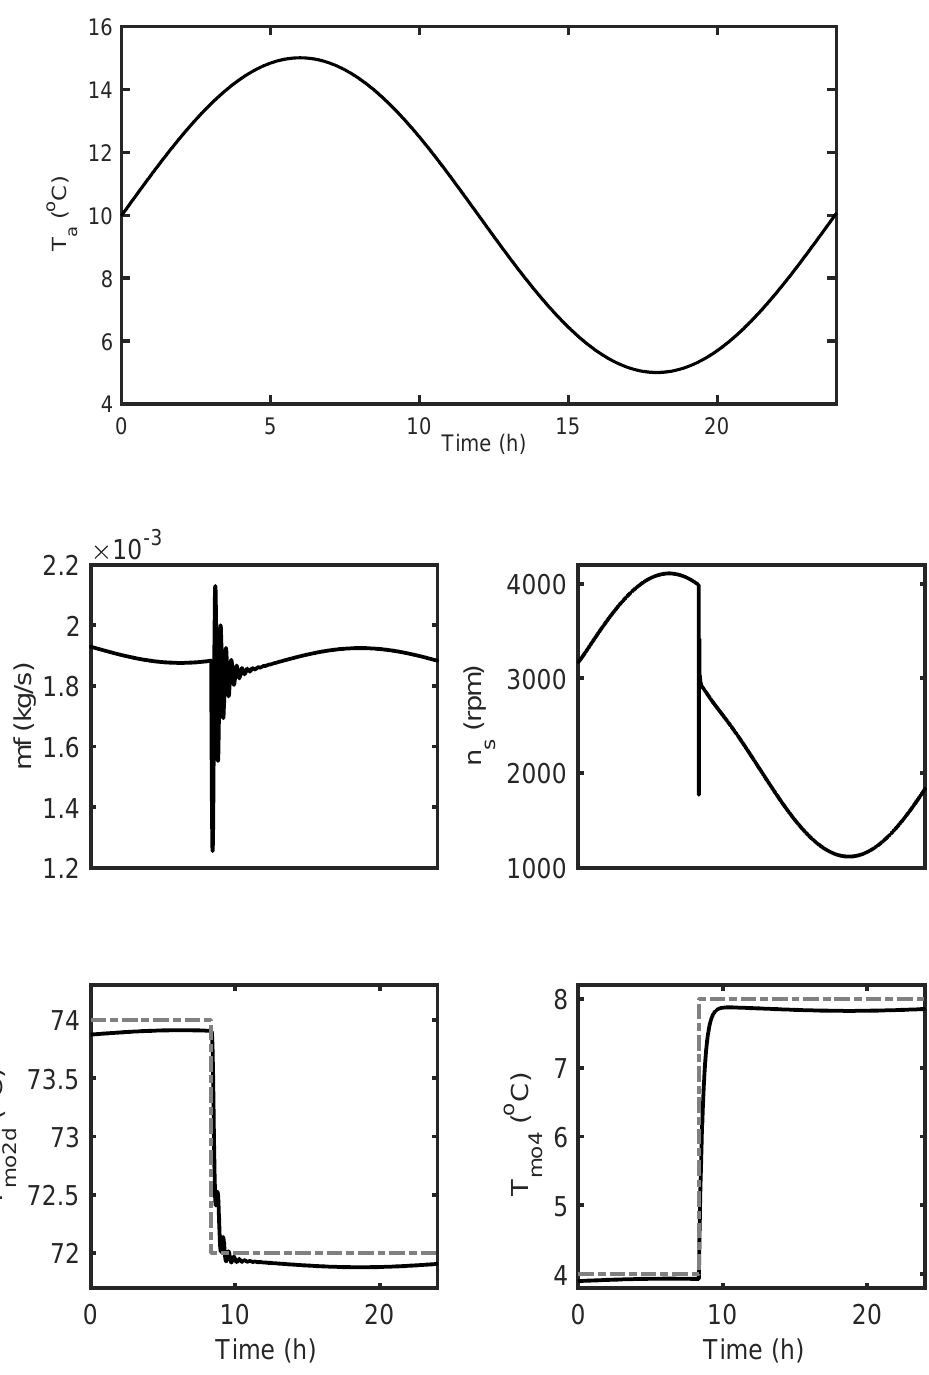
Figure 4. Process disturbance is the ambient temperature, T a ( top panel ). Controlled outputs are the temperature at the outlet of the holding tube, T mo2d ( bottom left panel ) and milk temperature at the outlet of the fourth heat exchanger, T mo4 ( bottom right panel ). Set-points for both T mo2d and T mo4 are reported with a grey dash-dotted line; manipulated inputs are fuel flow rate at boiler, m f ( middle left panel ), and rotating speed at the refrigeration rate, n s ( middle right panel ).